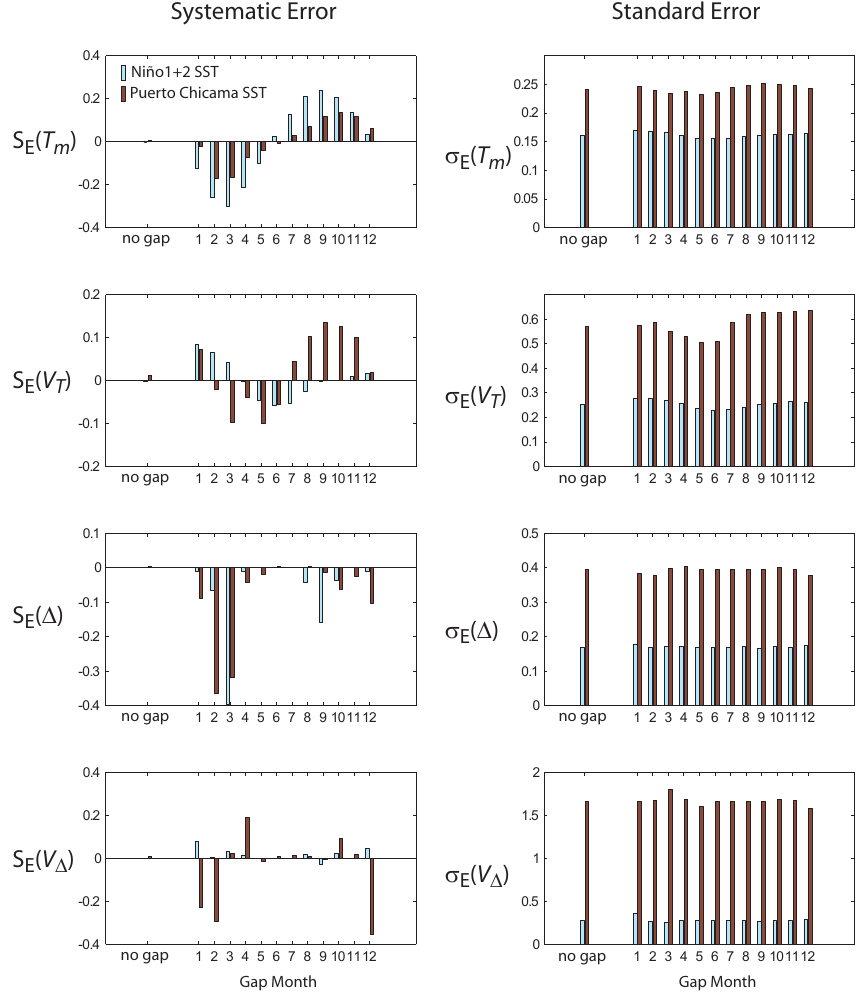
Fig. 5. Results of experiment 4. Standard and systematic errors for proxy reconstruction of T m , V T , 1 , and V 1 of Ni˜no1+2 SSTs (blue) and Puerto Chicama SSTs (red), versus the month of systematic growth